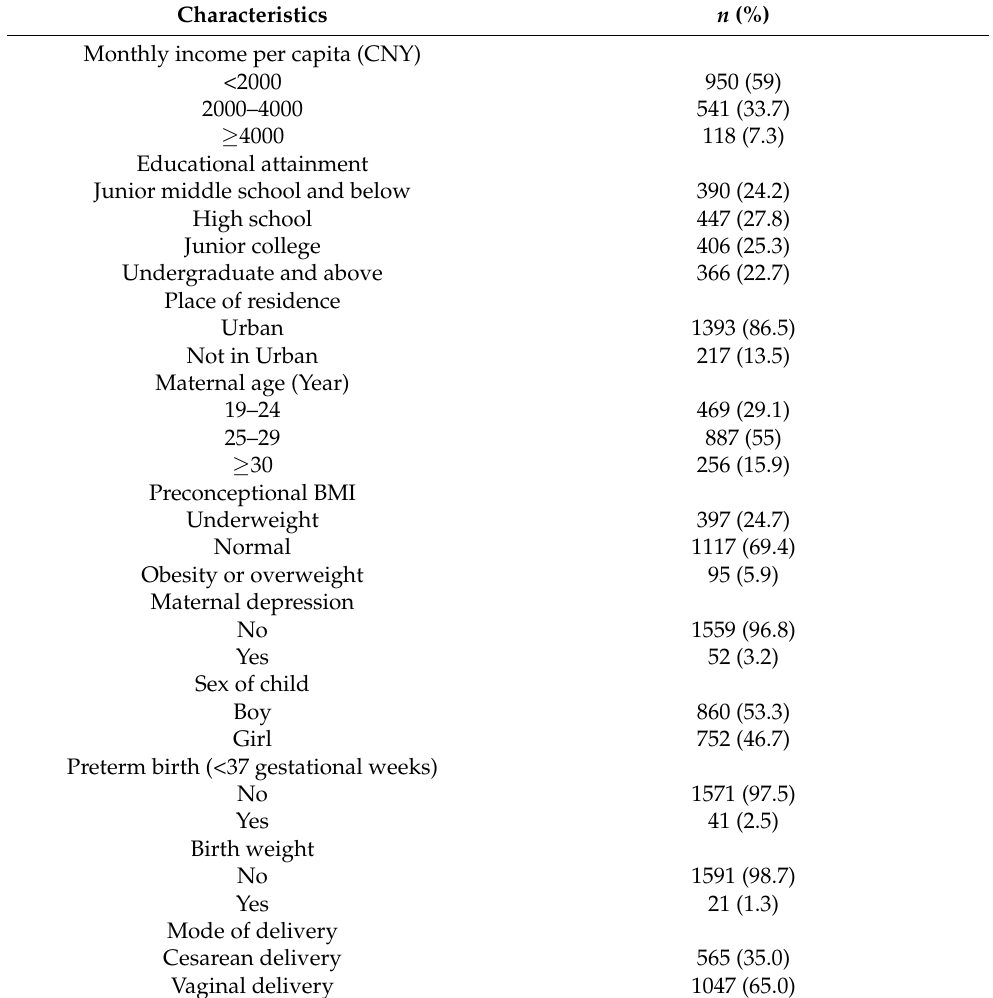
Table 1. Demographic characteristics of analysis samples, n